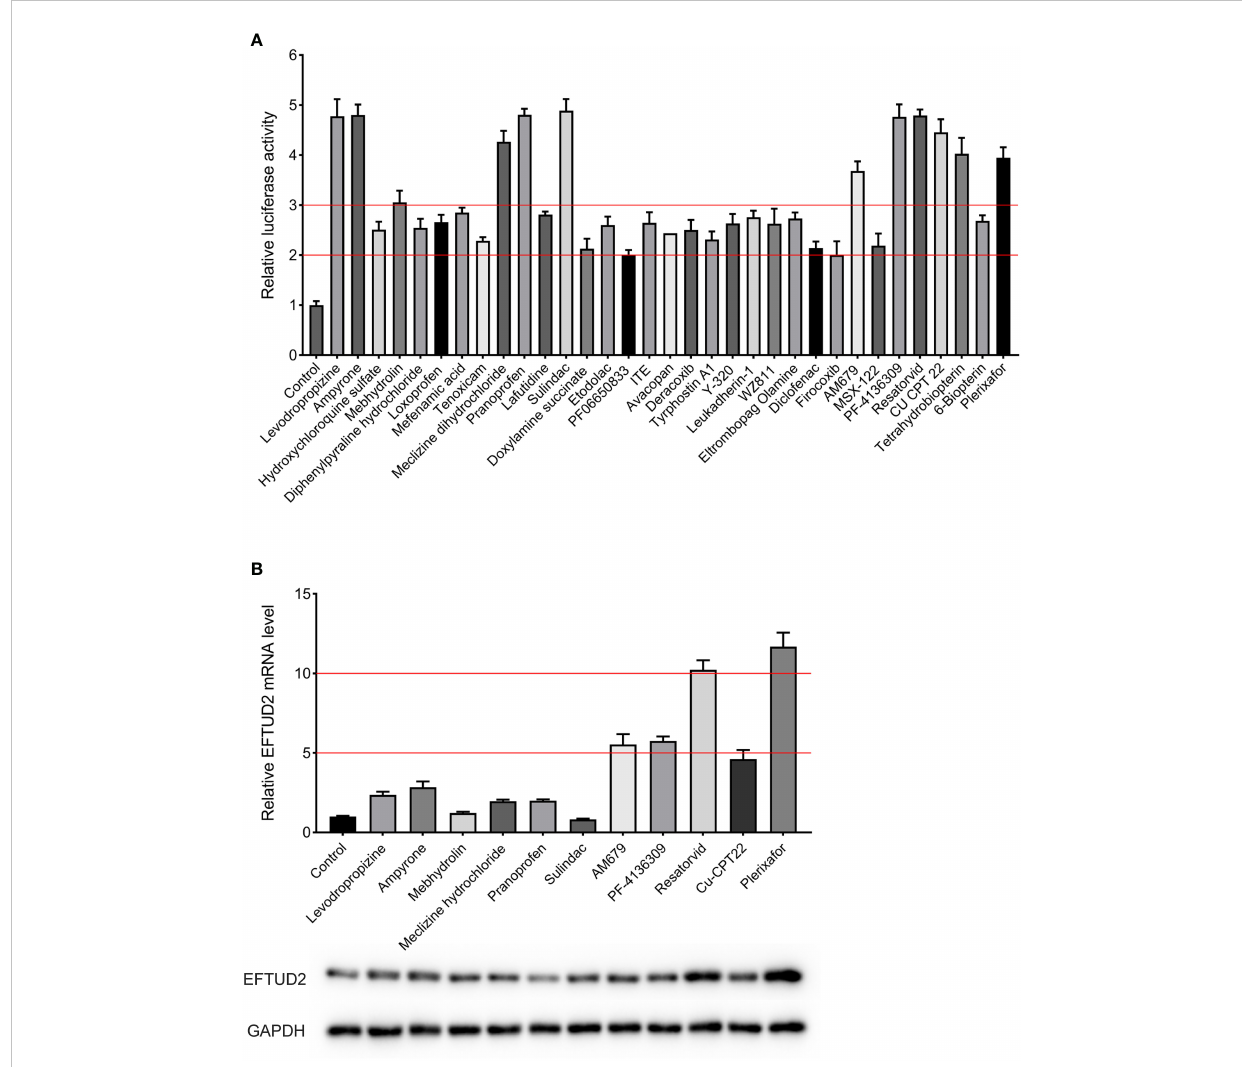
FIGURE 3 Screening compounds that upregulated the EFTUD2 promoter activity, genes, and proteins. (A) The luciferase analysis showed that 33 compounds increased the activity of the EFTUD2 promoter by more than two times, and 12 compounds increased the activity by more than three times. (B) Real-time PCR and Western blot analyses showed that plerixafor and resatorvid had the strongest ability to upregulate the activity of the EFTUD2 promoter among the 11 compounds (tetrahydrobiopterin was abandoned due to its obvious